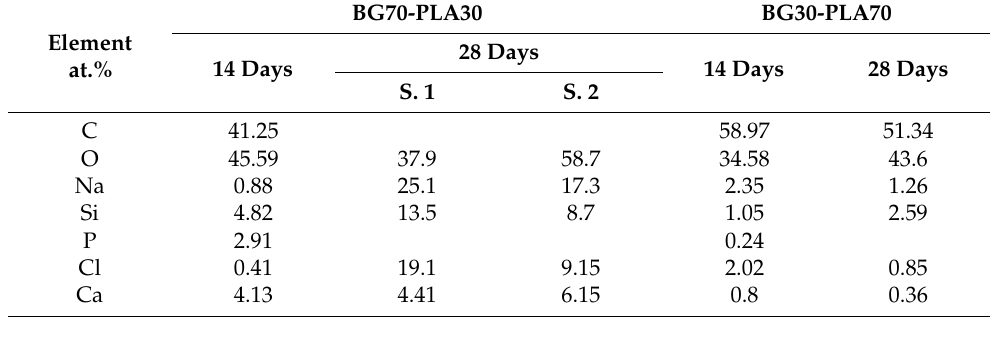
Table 5. EDS chemical analysis for BG-PLA composites after immersion in SBF.